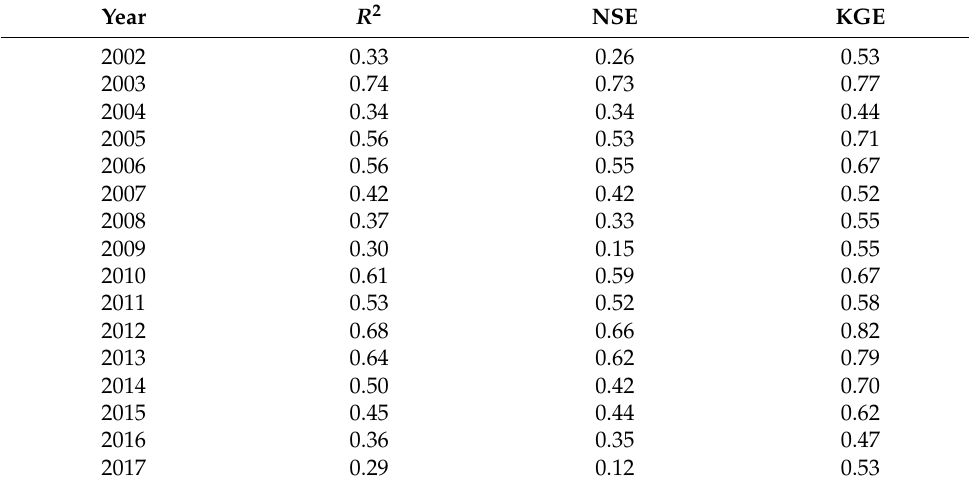
Table 2. Evaluation result of simulated daily flow of each year.